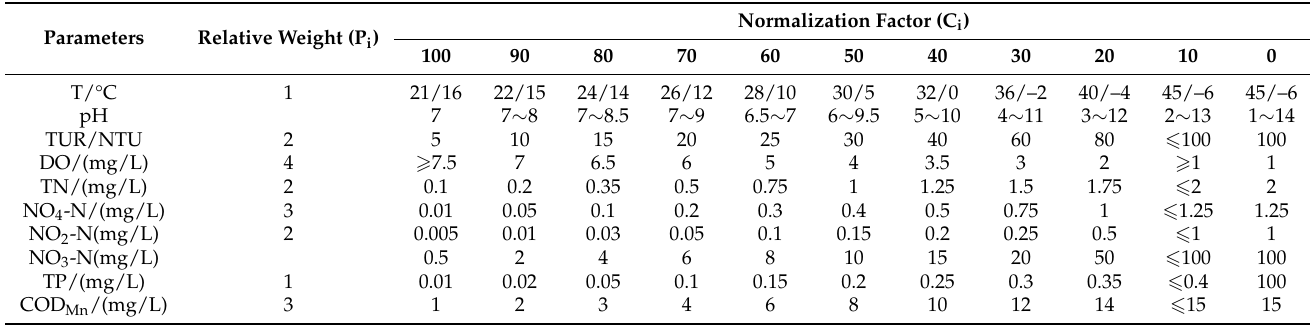
Table 2. WQI calculation table.